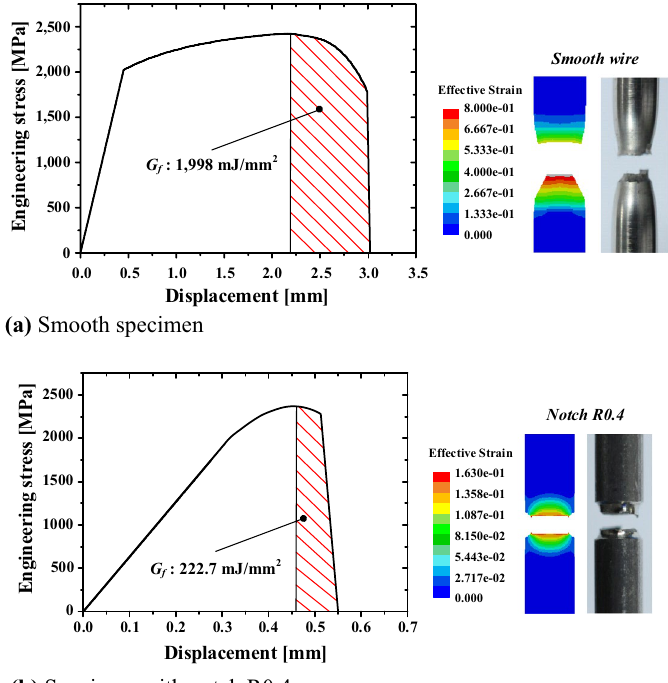
Figure 5. Fracture energy obtained through a tensile test and FE